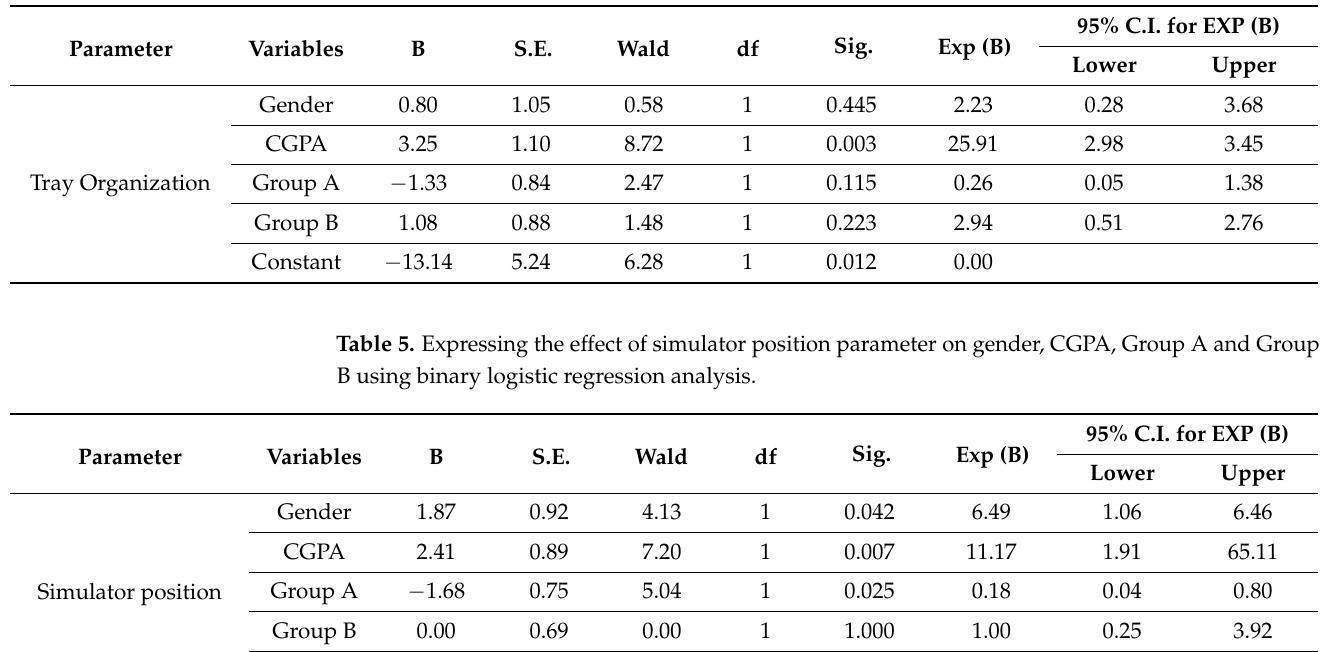
Table 4. Expressing the effect of tray organization parameter on gender, CGPA, Group A and Group B using binary logistic regression analysis.